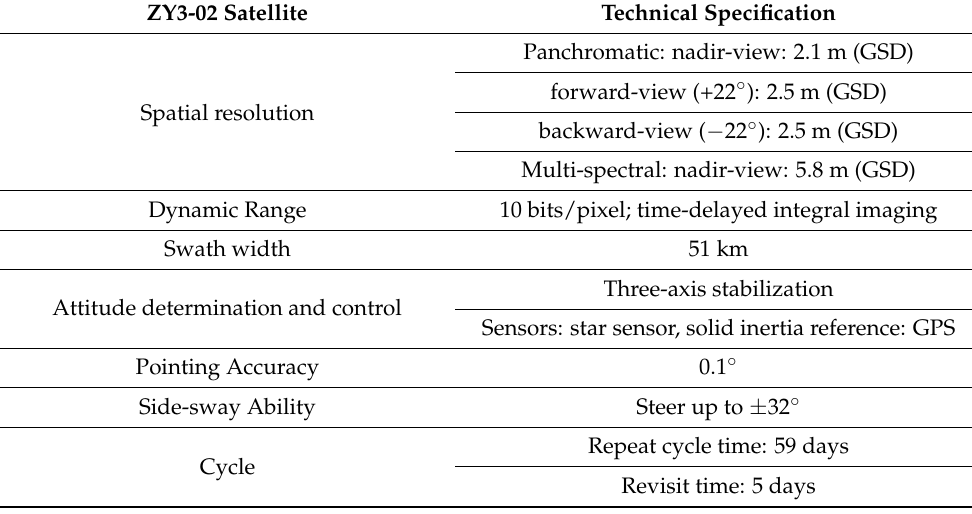
Table 1. the technical specification of ZY3-02 Satellite.